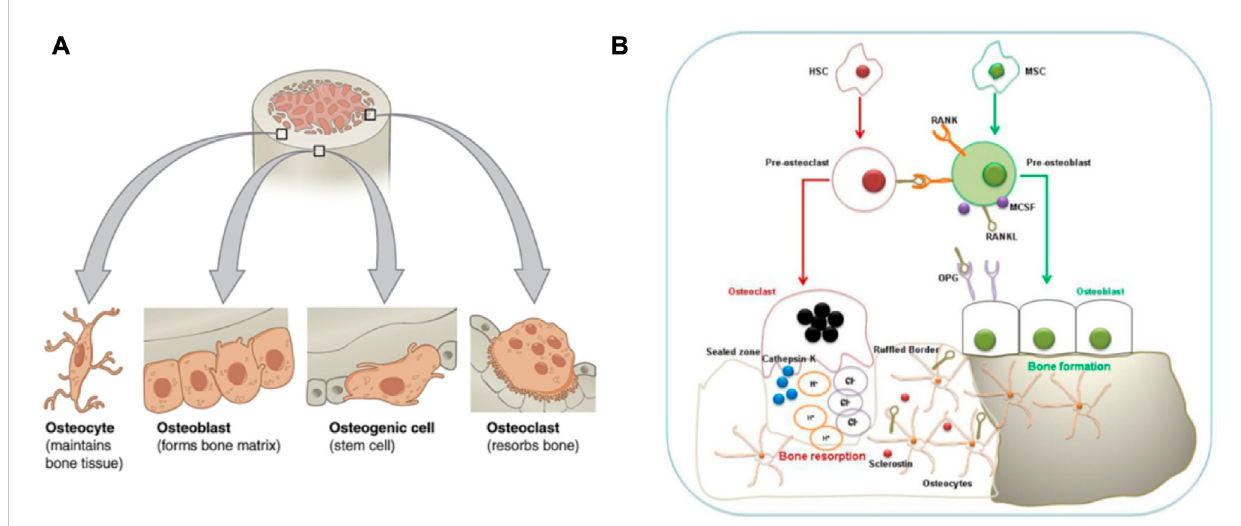
FIGURE 2 Bone remodeling and its involved cells. (A) :Four types of cells are found within bone tissue. (B) : Interaction between Osteoblasts-Osteoclasts- Osteocytes during bone remodeling. The graph was reprinted with permission from (Behzadi et al., 2017) and (Dar et al.,